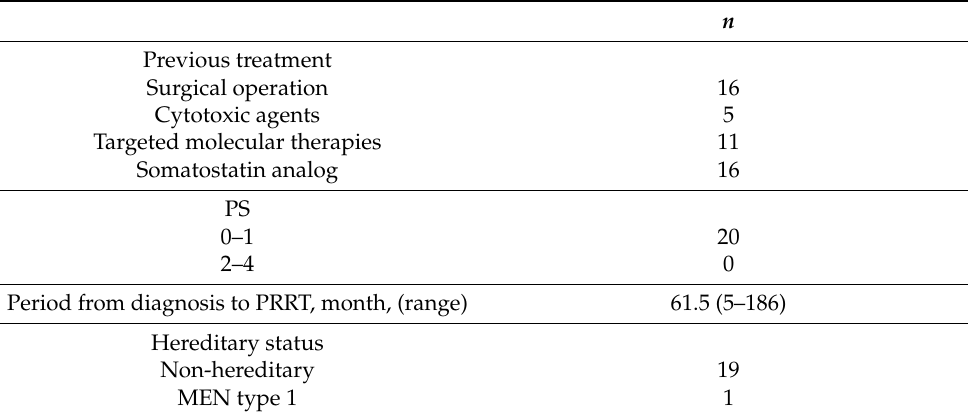
Period from diagnosis to PRRT, month, (range)